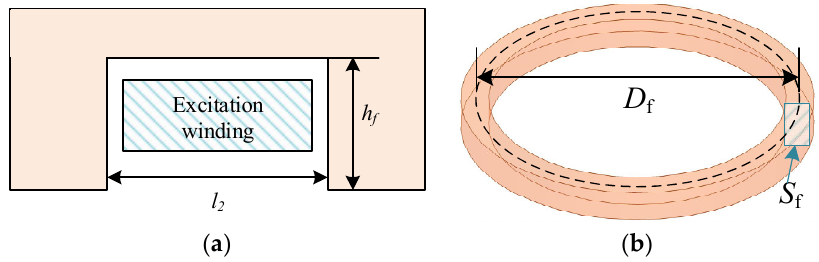
Figure 9. Excitation window and excitation winding. ( a ) Excitation window and its size. ( b ) Excitation winding.